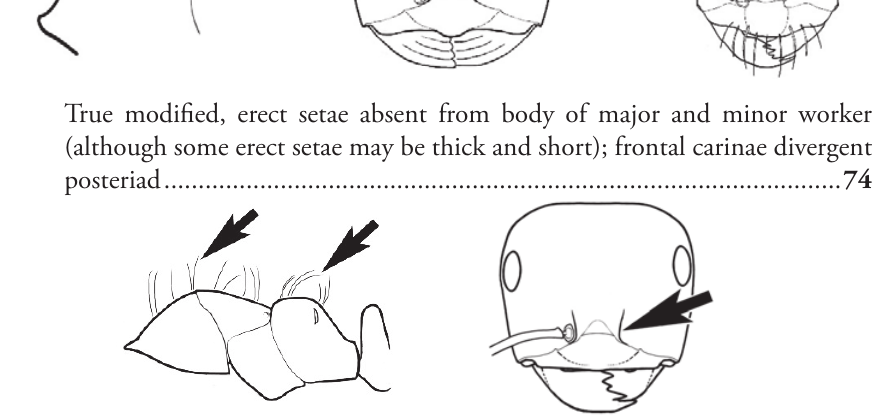
In full-face view, sculpture of major and minor worker head matt with microreticulate sculpture; frontal carinae weakly divergent posteriad; appressed setae on appendages sparse, thick and mostly separated from each other by more than their own length (inland WA) ( JDM 1247 ) (Fig. 71a–g) ..........